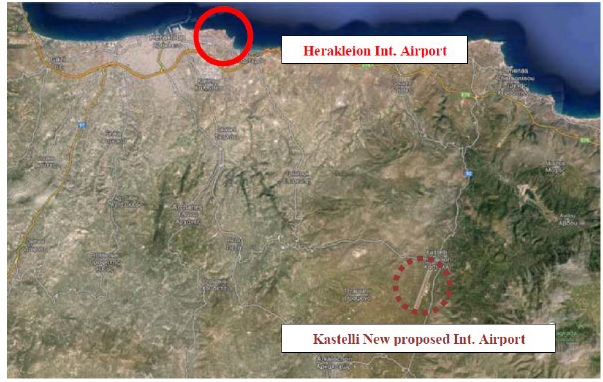
Fig. 15. Proposed location of the new airport of Herakleion at